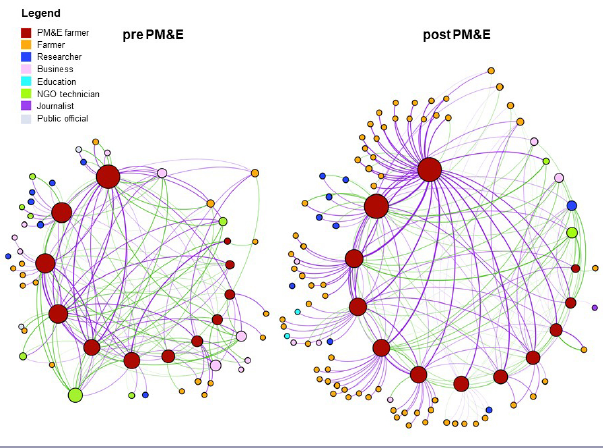
Fig. 4. Social networks of farmers involved in participatory monitoring and evaluation (PM&E) of regenerative agriculture. Pre PM&E = regenerative agriculture information fluxes of farmers ( N = 12) before initiating the PM&E project. Post PM&E = regenerative agriculture information fluxes of farmers ( N = 12) in the third year of taking part in the PM&E project. Centrality is the sum of absolute weights of in-going and out- going connections. Circle size indicates the relative centrality score of each person. Arrow thickness represents the relative strength of the information flux. Arrow color indicates the direction of the information flux: green = received, purple = shared.